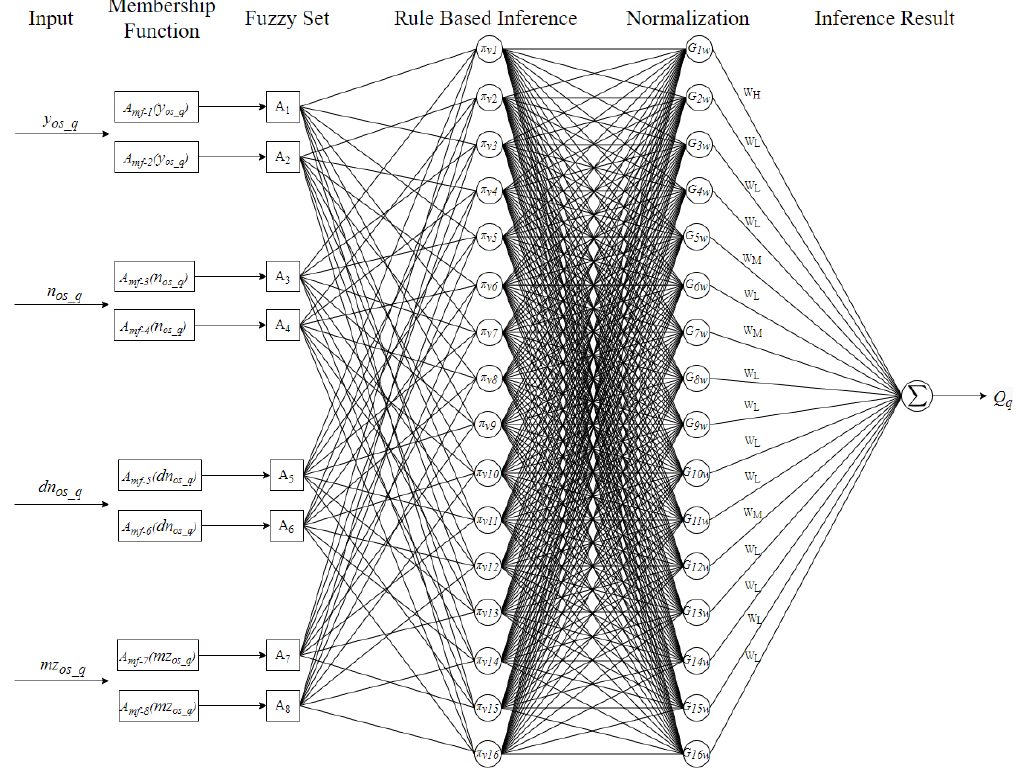
Figure 16. The framework of the ANFIS.